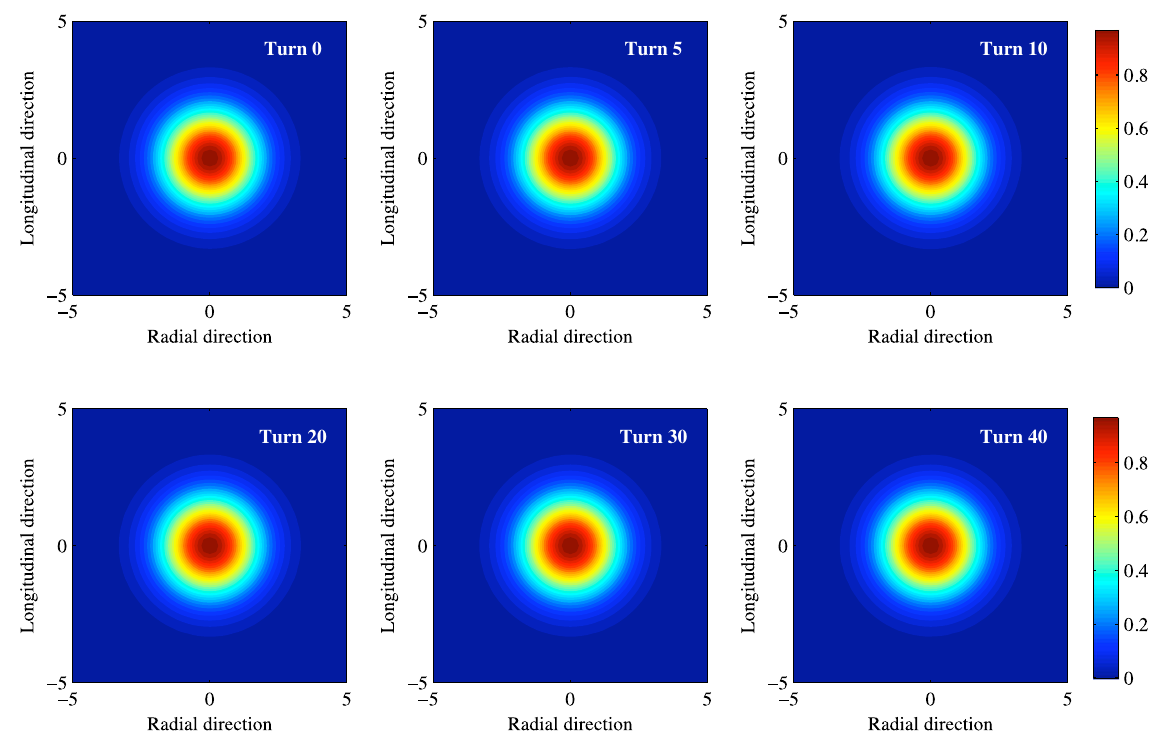
FIG. 5. Top view of a round coasting beam in the local frame moving with the beam center. Up: turn 0, 5, 10. Down: turn 20, 30, 40. To comparewithfiguresinRefs.[3,18],thebeam’stransportdirectionisalongthenegative y direction. (cid:4) 2 ¼ 0 : 8 and 2 (cid:9) x ¼ 2 (cid:9) y ¼ 2 : 52 mm